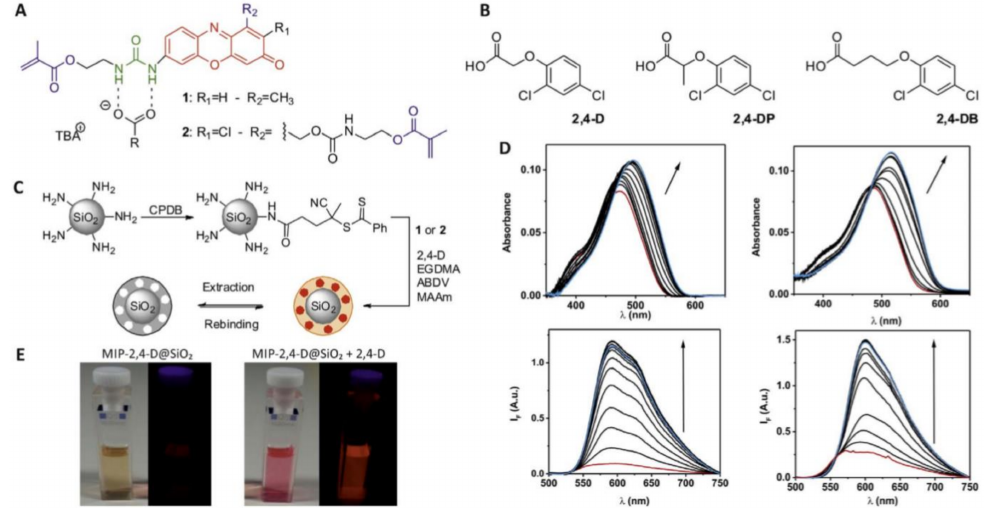
Figure 7. ( A ) Molecular architectures of the phenoxazinone monomer (1) and crosslinker (2). ( B ) Structures of 2,4-D and closely related compounds 2,4-DP and 2,4-DB. ( C ) Preparation of the core–shell microparticles from amine-modified silica microparticles with imprinting of the template into the MIP shell, followed by extraction (rebinding = analytical reaction). ( D ) Absorption and emission of (1) ( left ) and (2) ( right ) upon addition of 2,4-D/tertiary butyl alcohol (TBA) in CHCl3 ([1]=[2] = 5 µ M, [2,4-D/TBA] = 0–250 µ M). ( E ) Photographs of (2) in CHCl3 in the absence (left) and presence (right) of 2,4-D/TBA in daylight and under UV lamp (365 nm) illumination. Figure reproduced from [128] with permission from copyright Elsevier